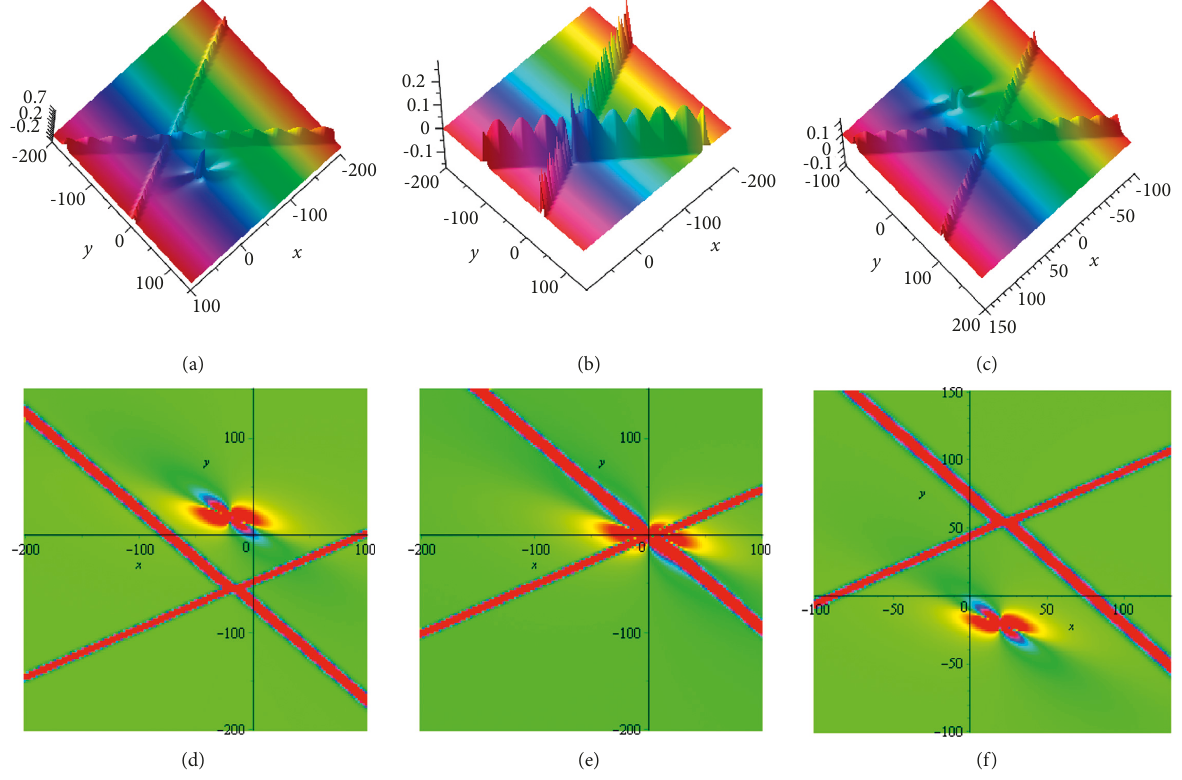
Figure 20: Plots of equation (81) by utilizing ϕ